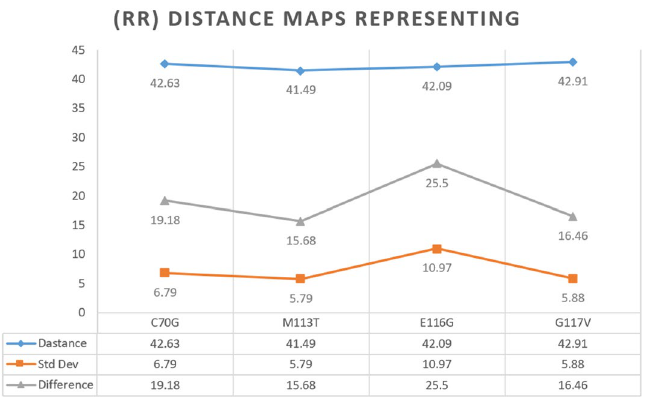
Figure 10. Difference RRDistMaps (for viewing and comparing protein distance) representing the difference between the PFN-1 WT and mutant forms of PFN-1. The difference between the Wild and mutant structures at the end of 50 ns MD is 20.27 for the E116G mutation, which is 11 for the C70G mutation, 13.4, and 15.21 for the G117V and M113T mutations, respectively.